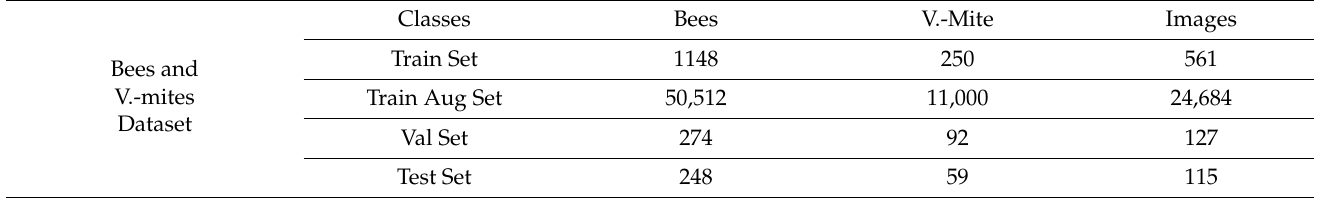
Table 2. The table shows the number of annotated objects of given classes of the Bees and varroosis dataset.